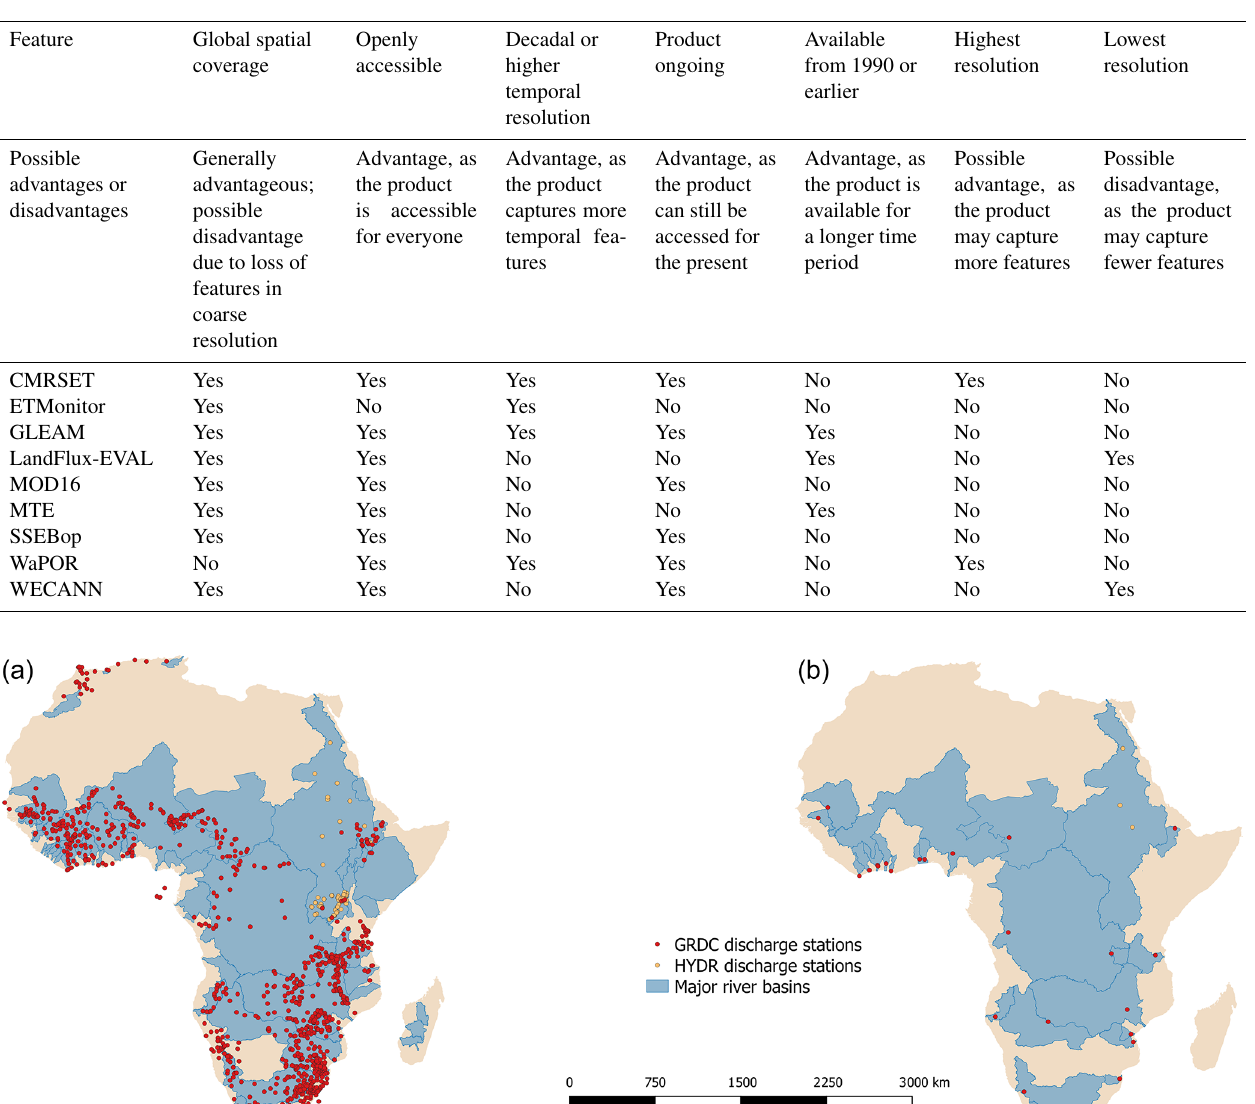
Table 1. Characteristics of evapotranspiration products. Feature